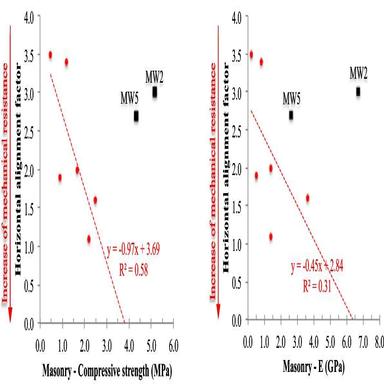
Configuration of the horizontal joints expressed by the vertical alignment factor versus the compressive strength (left) and Young's modulus (right) values of the tested masonry walls.